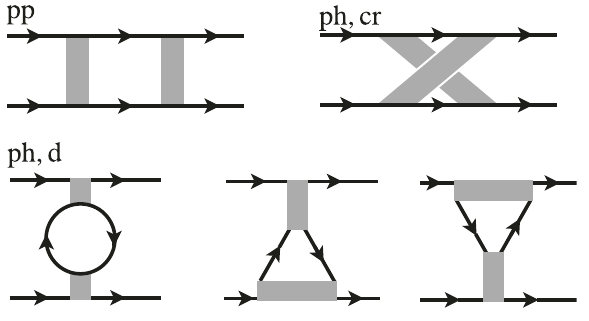
Fig. 4 Loop diagrams. Contributing to the functional RG fl ow, cf. Eq. (5).